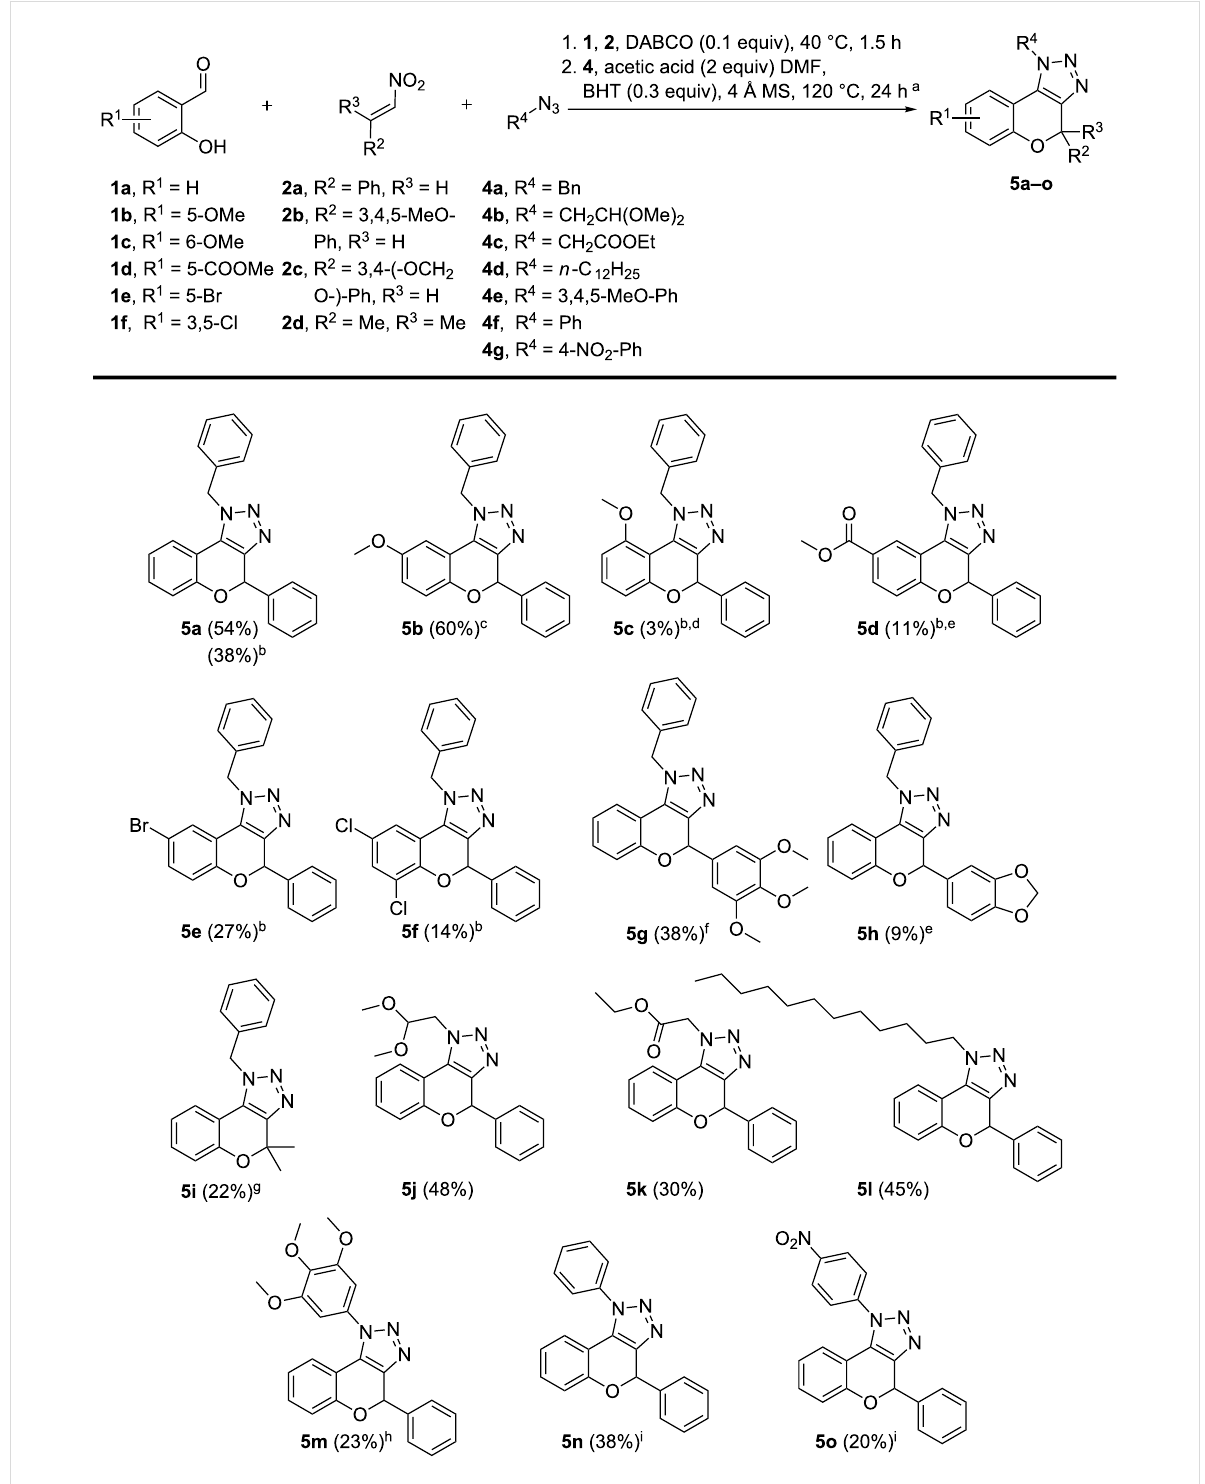
Figure 1: Scope with respect to various salicylaldehydes 1a – f , nitroalkenes 2a – d and organic azides 4a – g . a Reaction conditions for two-step one-pot procedure: 1. 1 (1.2 equiv), 2 (1 equiv), DABCO (0.1 equiv), 1.5 h, 40 °C; 2. 4 (2 equiv), acetic acid (2 equiv), BHT (0.3 equiv), 4 Å MS (50 mg), DMF (0.1 mL), 24 h, 120 °C. b Reaction conditions for two-step one-pot procedure with solid salicylaldehydes: 1. 1 (1.2 equiv), 2 (1 equiv), triethylamine (2 equiv), 1.5 h, 40 °C; 2. Same as for a . c Reaction time for the second step: 27 h. d Reaction time for the first step: 24 h; second step: 29 h. e Reaction time for the first step: 2 h. f Reaction time for the first step: 3 h. g Reaction time for the first step: 38 h. h Reaction time for the second step: 30 h. i Reaction time for the second step: 45